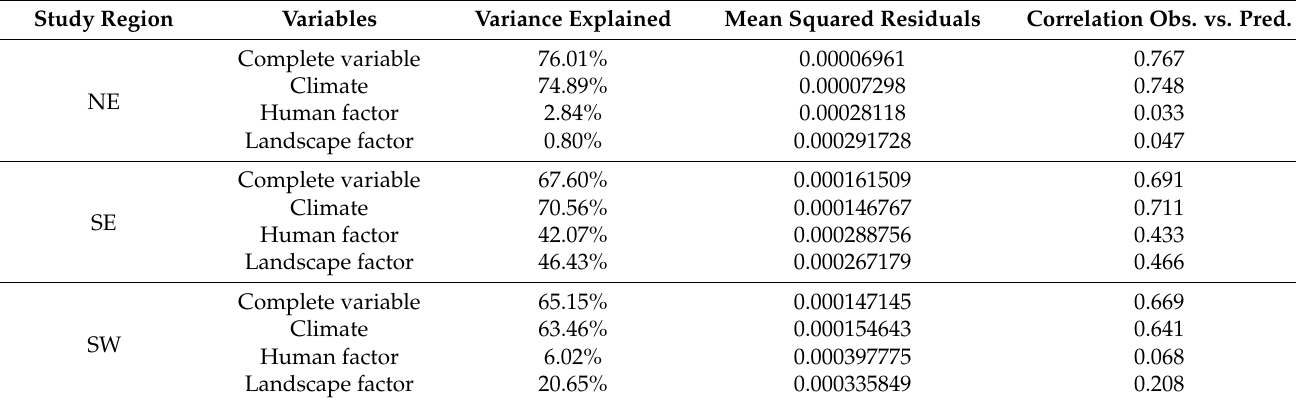
Figure 2. Variable importance measures (%IncMSE- Increase in Mean Square Error) of climate factors derived from Random Forest analysis in different regions ( a ). Comparison of the relative importance of variables to fire occurrence (pie charts) and the relative importance of each variable among three regions (different portions within each pie chart) ( b ). The bars below each pie chart represent the standard deviation of the relative importance of each variable among the three regions. %IncMSE (x-axis) quantifies the importance of a variable by measuring the change in prediction accuracy when the values of the variable are randomly permuted compared with the original observations. Abbreviated variable names are described in Table 2. Table 3. Results of the models created with Random Forest under different category of variables in each region, including the correlation values between observed (obs) and predicted (pred) values. Study Region Variance Explained Mean Squared Residuals Correlation Obs. vs.